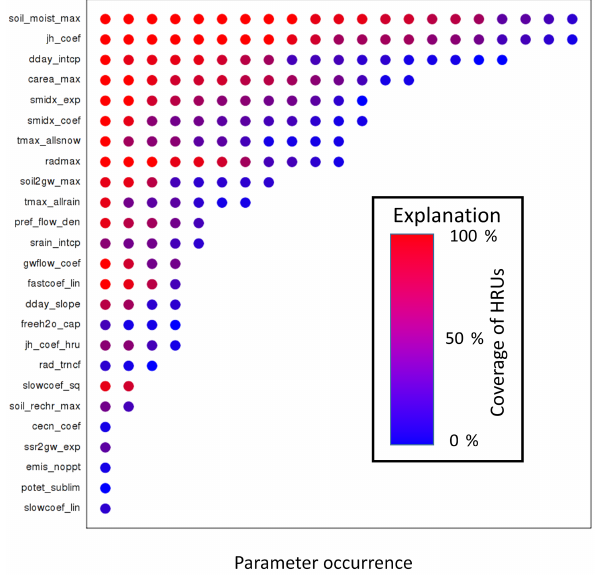
Figure 4. Summarizes the frequency of occurrence of the different calibration parameters in the process and/or performance statistic categories of Table 2. The circles in each row adjacent to a parame- ter name indicate how many times the respective parameter occurs in these different categories. Parameters with more circles are af- fecting more process categories. The color of each circle indicates the extent of the spatial coverage of that occurrence; specifically, red circles (as opposed to blue) indicate that more Hydrologic Re- sponse Units are affected by the respective